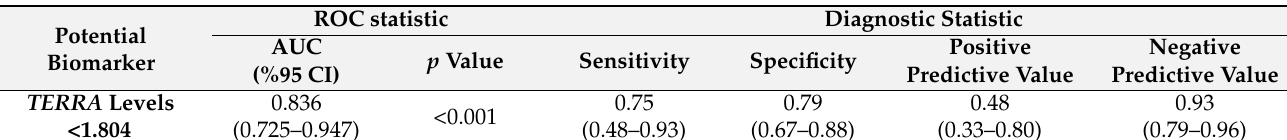
Table 5. ROC analysis results for TERRA levels in predicting rapid progression in ADPKD patients; AUC: area under the curve, ROC: receiver operating characteristic, CI: confidence interval.